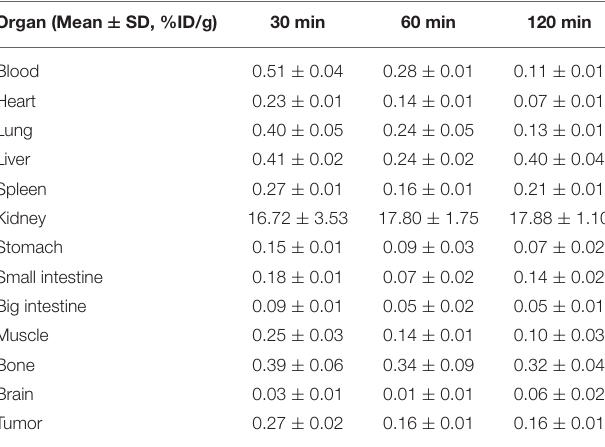
TABLE 2 | Biodistribution of the [ 18 F]AlF-NOTA-HER2 affibody in mice-bearing MKN74 tumors. Organ (Mean ± SD,